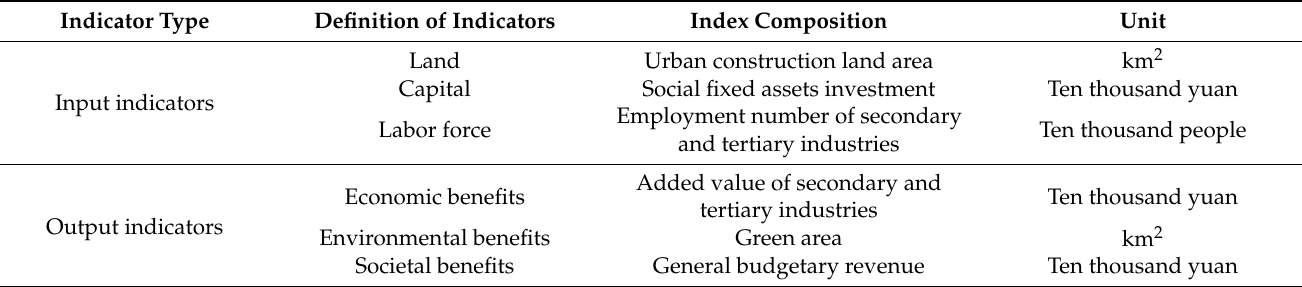
Table 1. Input–output index system of